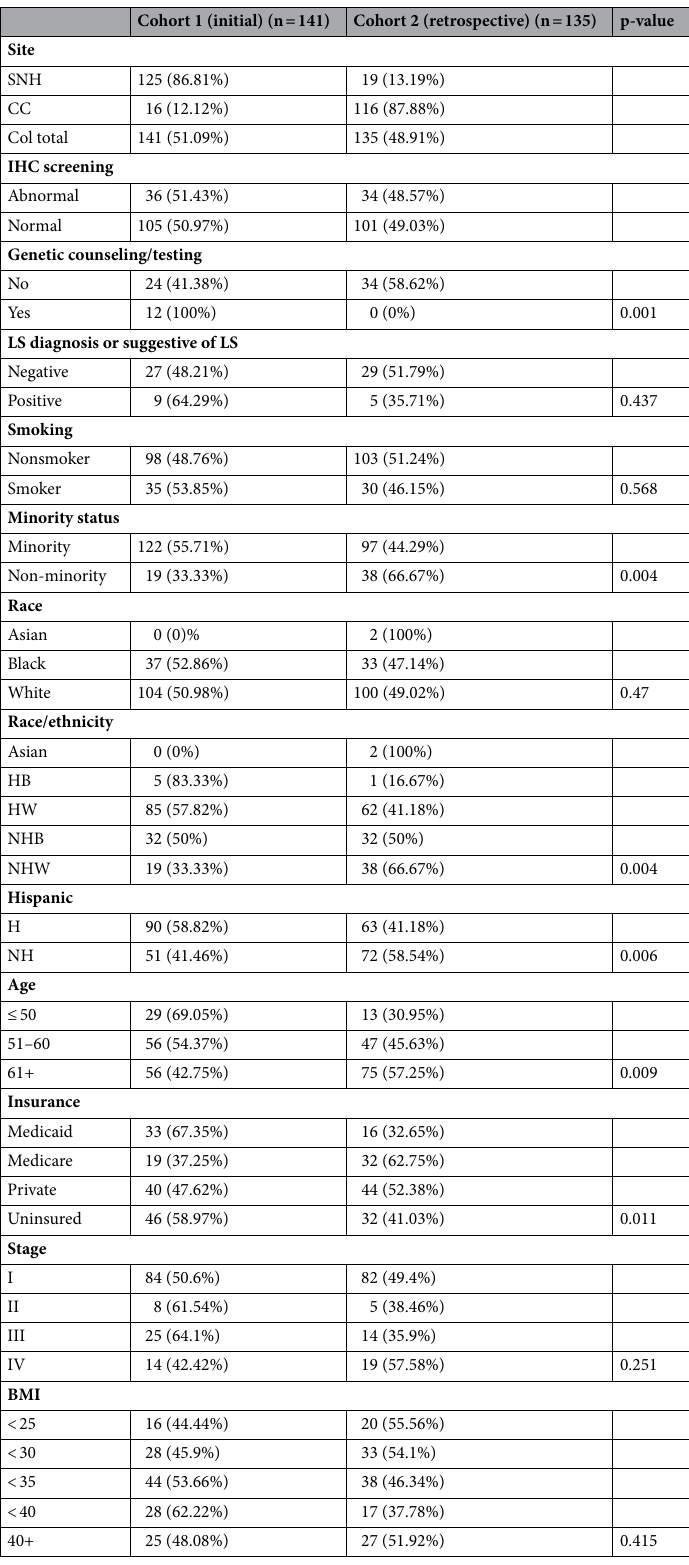
Table 2. Demographic characteristics of patients originally screened as part of routine cancer care and those retrospectively screened as part of this